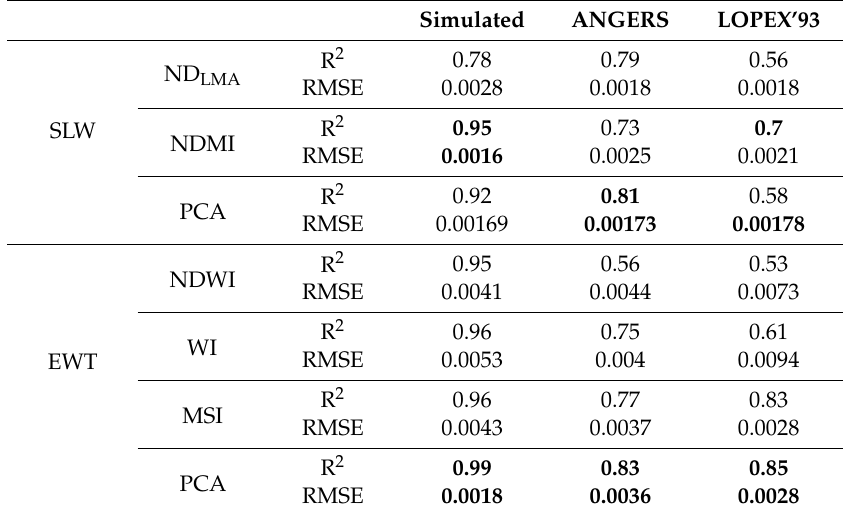
Table 6. Results for the validation of the accuracy of the VI-based models of specific leaf weight (SLW) and equivalent water thickness (EWT).